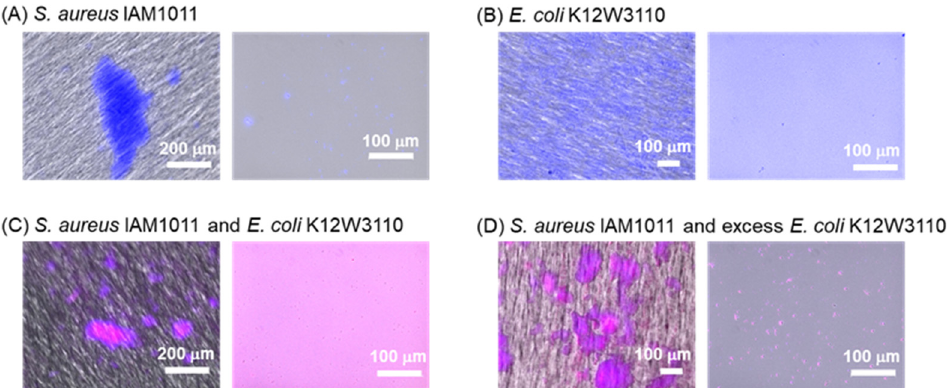
Figure 11. Microscope images of filter and filtrate using BenzoB-PAMAM(+) at a pH of 7.4, adjusted with PBS. [BenzoB-PAMAM(+)] = 3.3 × 10 − 6 M. From left to right: merged microscopy images of filter and filtrate samples. ( A ) 1.4 × 10 8 CFU · mL − 1 of S. aureus IAM1011 stained with DAPI. ( B ) 3.0 × 10 8 CFU · mL − 1 E. coli K12W3110 stained with DAPI. ( C ) 1.0 × 10 8 CFU · mL − 1 S. aureus IAM1011 (DAPI) and E. coli K12W3110 (EB). ( D ) 1.4 × 10 8 CFU · mL − 1 S. aureus IAM1011 (DAPI) and 3.0 × 10 8 CFU · mL − 1 E. coli K12W3110